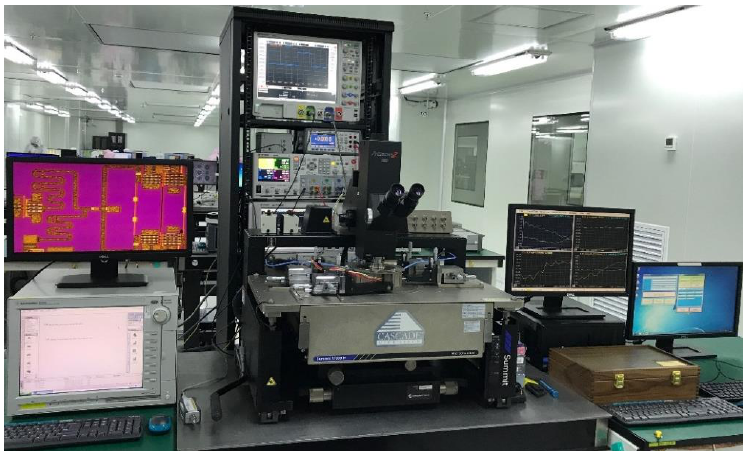
Figure 18. The photo of the all-in-one solution.